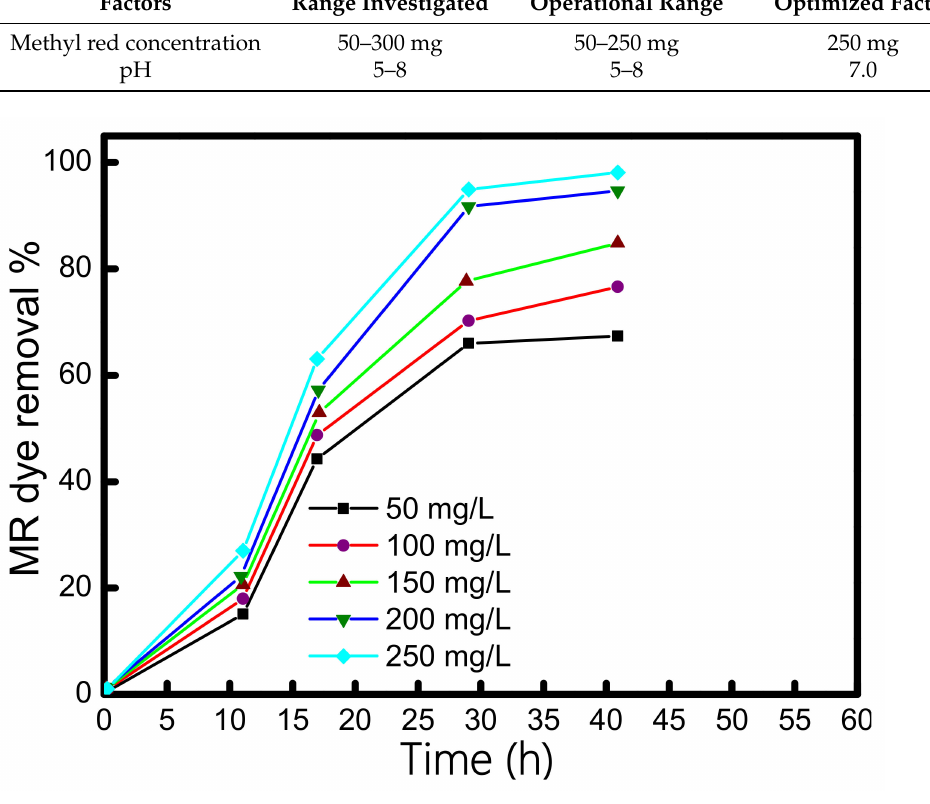
Figure 3. Methyl red dye decolorization in percentage by an incubation period in sMFC at 7 pH using